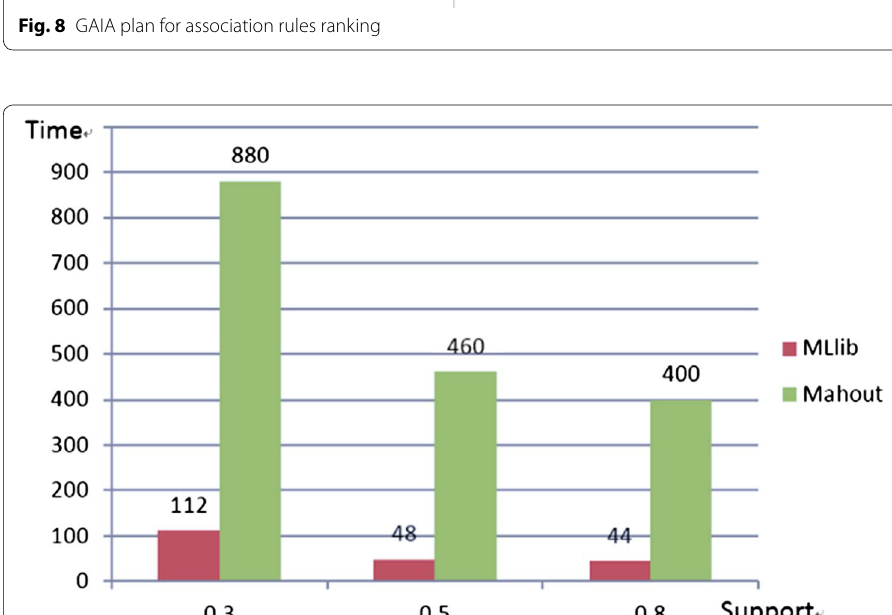
Fig. 9 Running times for different support